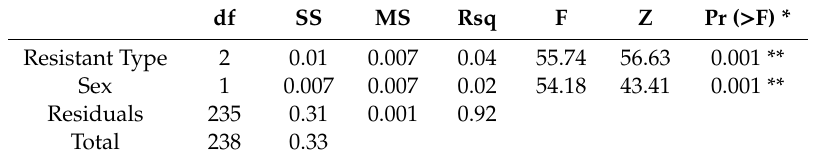
Table 1. Procrustes ANOVA for both centroid size and shape of codling moth